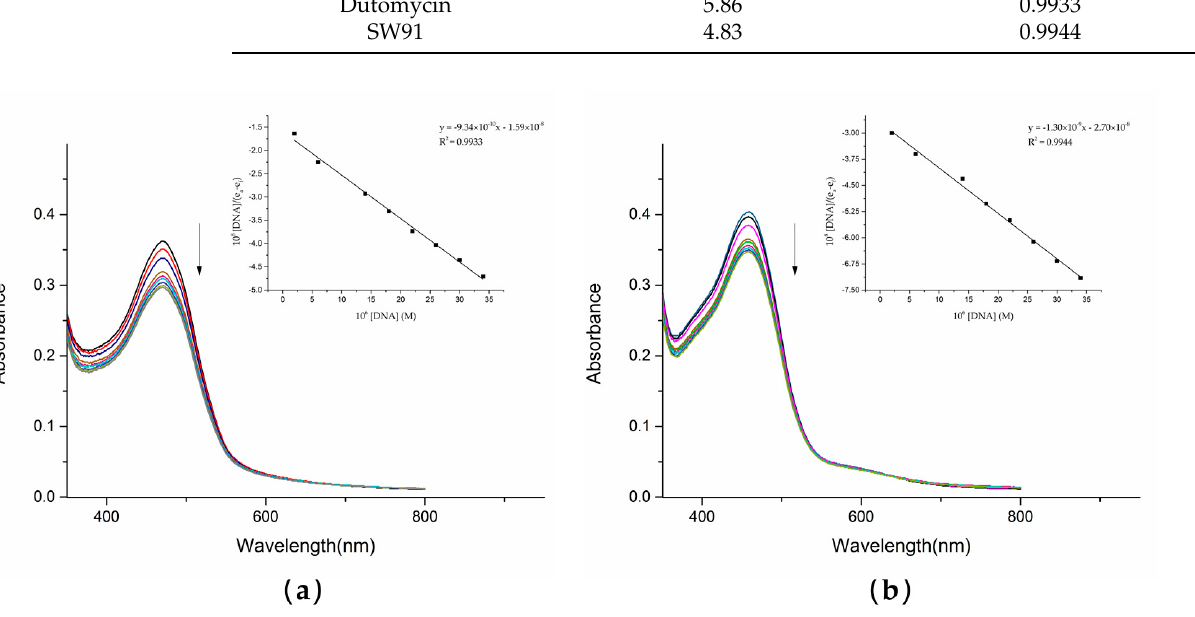
Figure 6. As the concentration of CT-DNA (0–34 μ M) increases, the absorption spectra of dutomycin (90 μ M) and SW91 (120 μ M) change. The arrows’ direction indicates the increasing concentrations of DNA: ( a ) as the concentration of CT-DNA increases, the absorbance of the dutomycin system changes; ( b ) as the concentration of CT-DNA increases, the absorbance of the SW91 system changes. Table 2. Binding constant K b values of compounds dutomycin and SW91 interacting with CT-DNA.